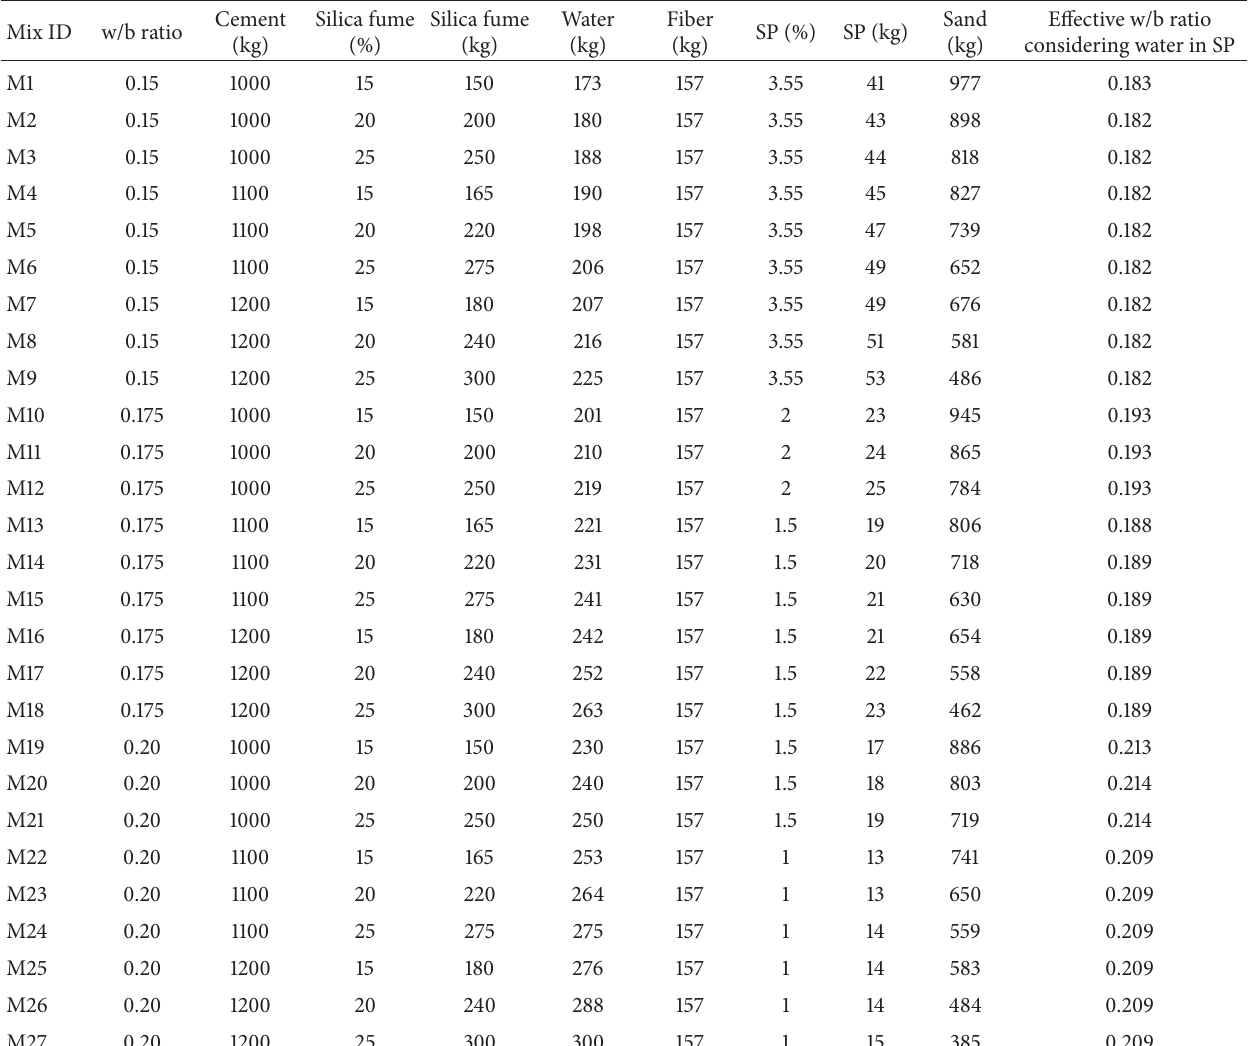
Table 3: Weights of the constituents of 27 RPC mixtures (for 1m 3